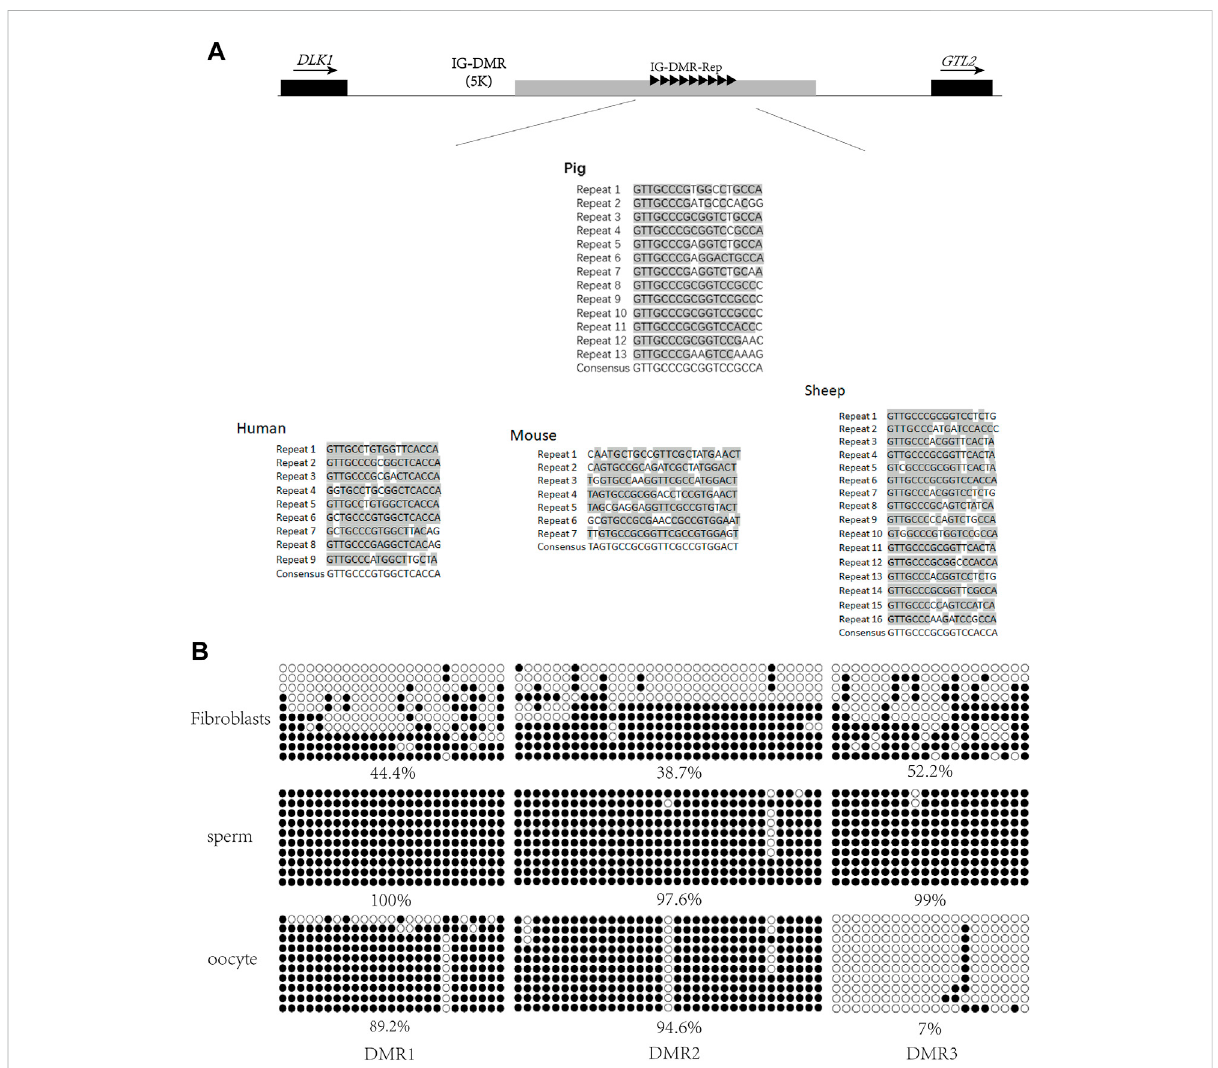
FIGURE 1 Screening of porcine IG-DMR. (A) Analysis of the IG-DMR tandem repeat sequences in pigs by interspecies conserved sequences. The black squaresrepresentthepositionsof DLK1 and GTL2 ,respectively.Thearrowdirectionisthegenetranscriptiondirection.Thegrayrectanglerepresents the IG-DMR candidate region (5 kb). The black triangle represents the conserved interspecies tandem repeat sequence, and the gray areas of the tandem repeat sequences in human, mouse, sheep, and pig are the conserved sequence dinucleotides. (B) Analysis of methylation in porcine fi broblasts, sperm, and oocytes Each circle represents a CpG dinucleotide. The degree of methylation (%) is based on methylated CpGs/all CpGs; open circles indicate unmethylated CpGs and fi lled circles indicate methylated